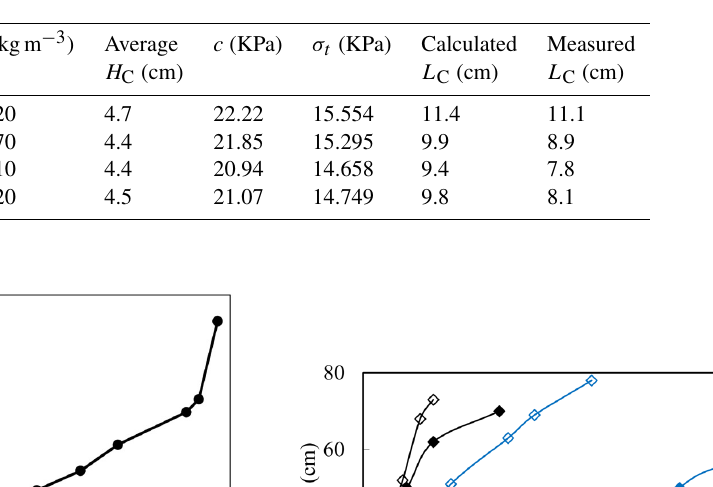
Figure 5. Headcut type: (a) single headcut with single jet; (b) multiple-step headcut with single jet; (c) multiple-step headcut with multiple jets; (d) single headcut with single jet. Table 2. Calculated critical cantilever length